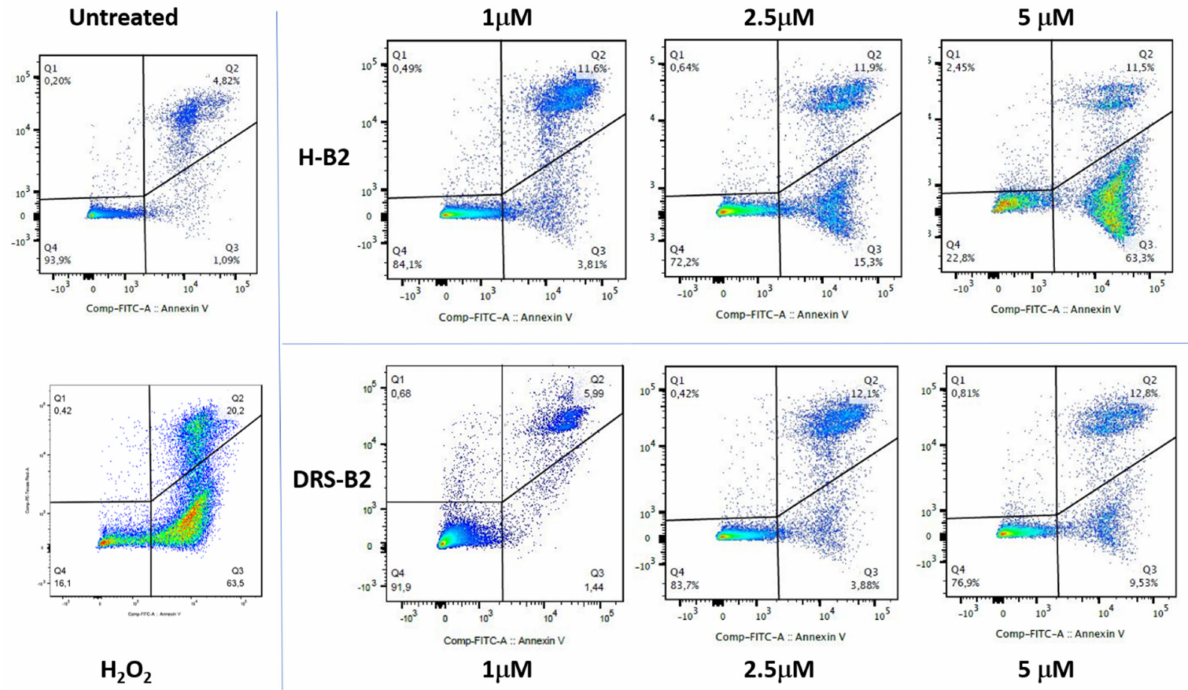
Figure 9. PC3 cell viability after H-B2 and DRS-B2 treatments. PC3 cells were treated with different concentrations of H-B2 or DRS-B2. H 2 O 2 was used as a positive control for apoptosis. Twenty-four hours after treatment, cells where double stained with FITC-Annexin-V (A-V) and Propidium Iodide (PI) and analyzed by flow cytometry. The cell viability of PC3 cells was observed by measuring the amount of A-V and PI negative and positive cells. Dot plots of A-V/PI double staining after PC3 treatment with the different concentrations or H-B2 or DRS-B2 for 24 h. All experiments were performed three